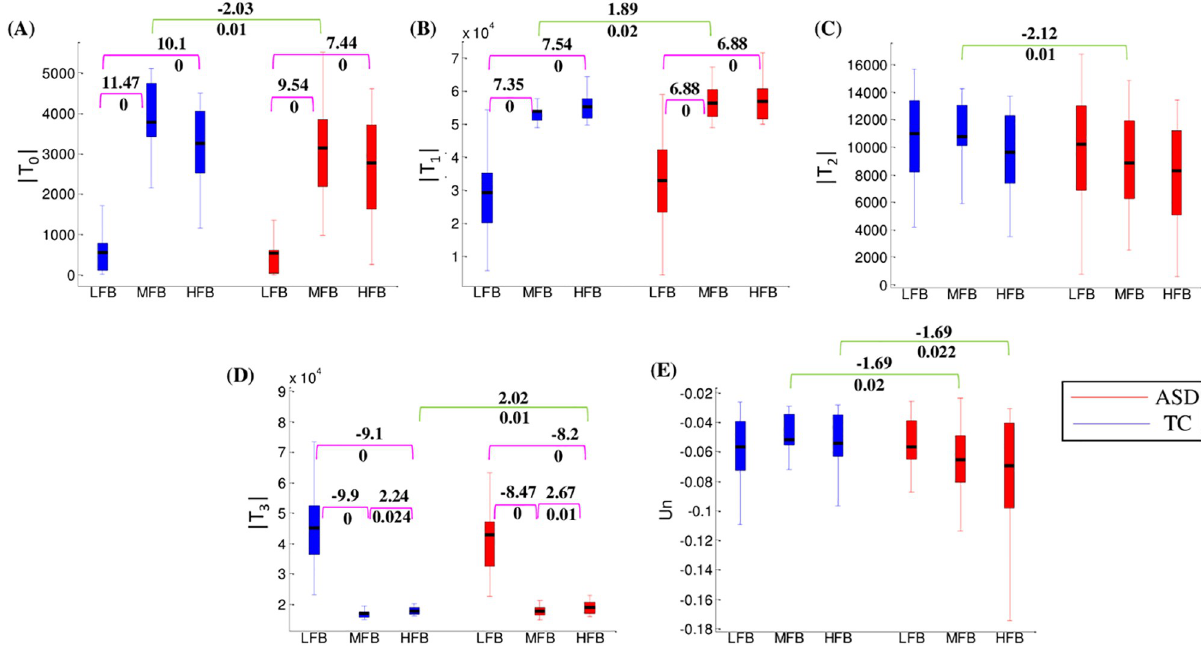
Fig 4. Comparing the triadic interaction metrics between groups and between graph frequency bands. The results are for (A) |T 0 |, (B) |T 1 |, (C) |T 2 |, (D) |T 3 |, and (E) Un metrics. The green and pink color lines show the results between groups and frequency bands, respectively. The values above and under the lines are statistical t and corresponding corrected p values, respectively. The values mentioned above are only provided for significant results (p <